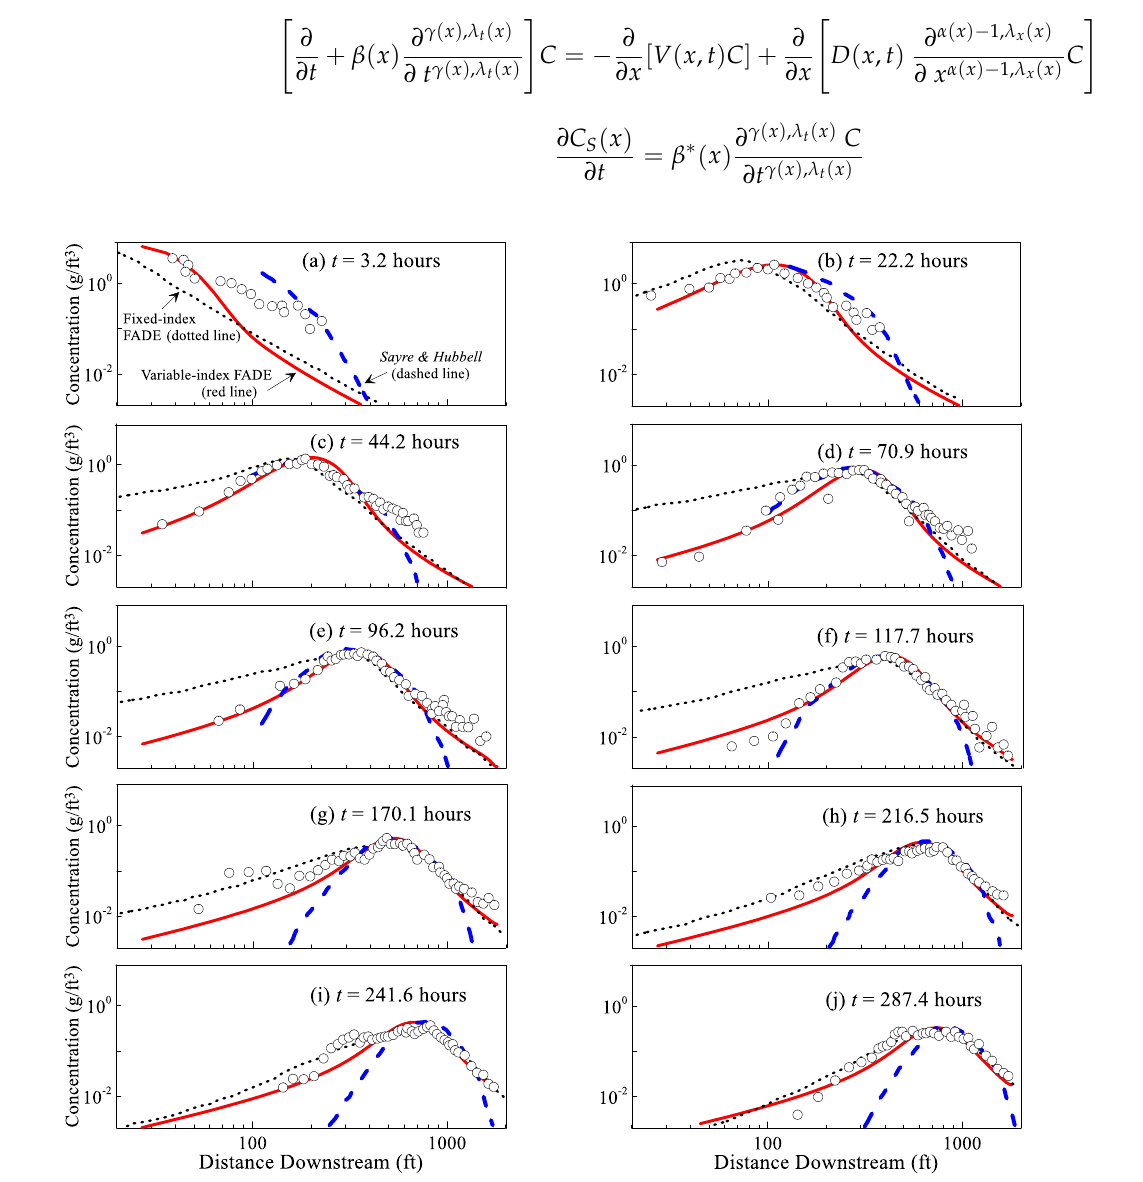
Figure 2. Application 1: Modeled (red lines, using the variable-index fractional advection-dispersion equation (FADE) (4)) versus measured (circles, by Sayre and Hubbell [47]) snapshots of bed sediment at the North Loup River, Nebraska at ten sampling cycles ( a – j ). For comparison purposes, the results of the FADE (4) with a fixed index (dotted lines) and the original mode (without considering anomalous diffusion) from Sayre and Hubbell [47] (dashed lines) are also shown.